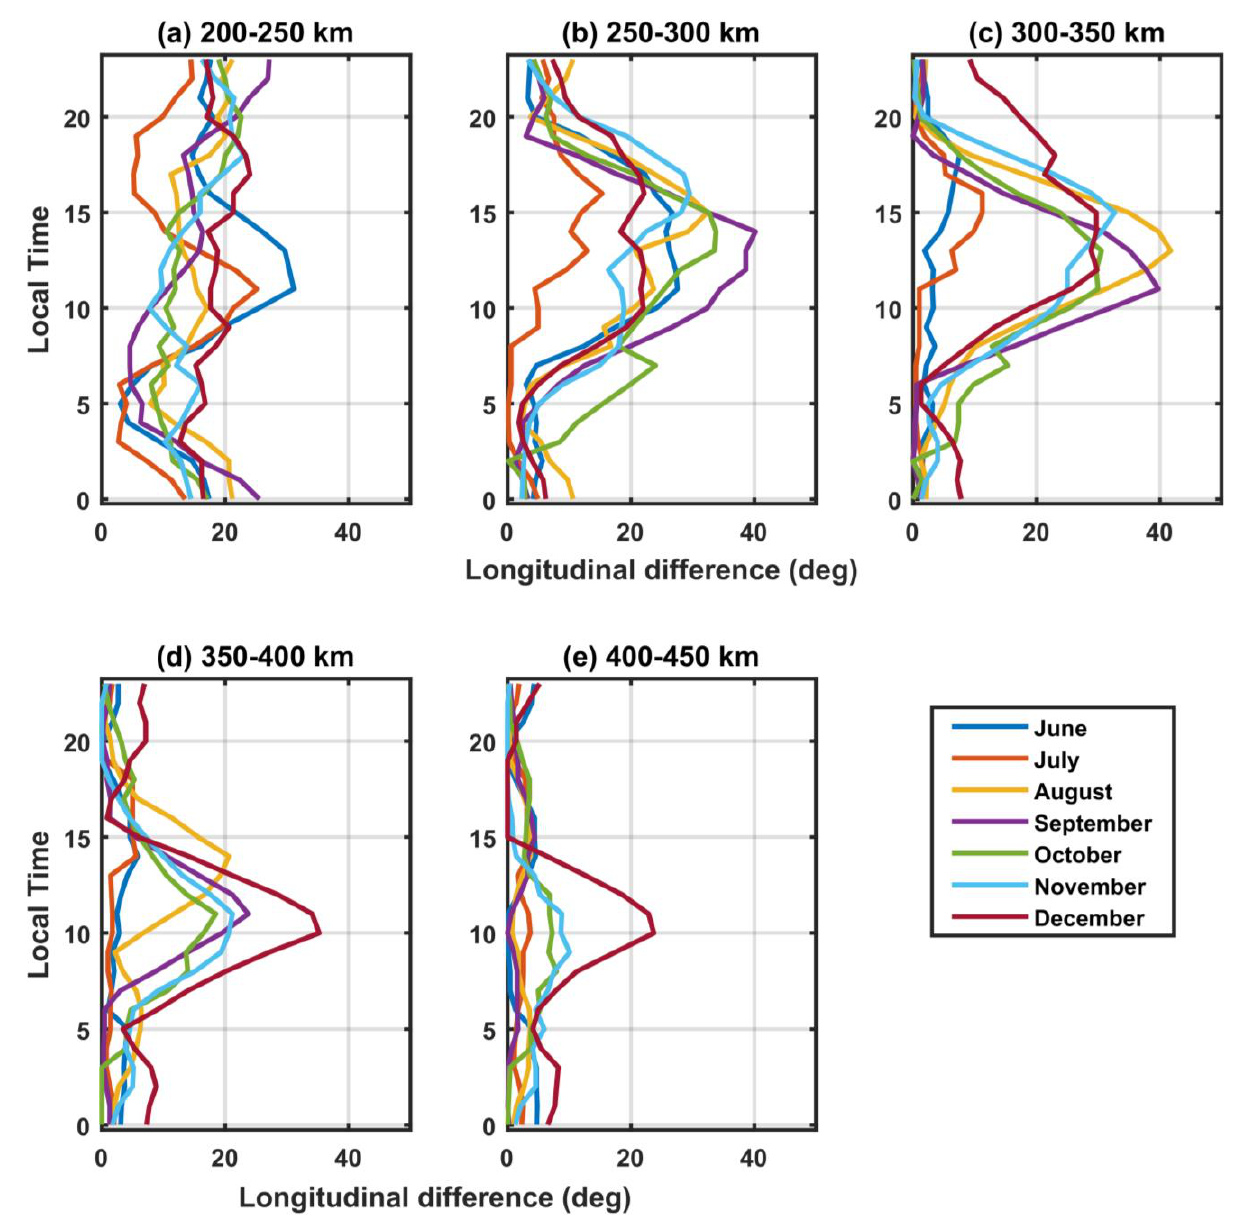
Figure 9. ( a – e ) Local-time variation of the longitudinal difference between the WN4 component in the EIA crest and trough regions at 5 different altitude bands. Different months in 2020 are indicated with different colors.